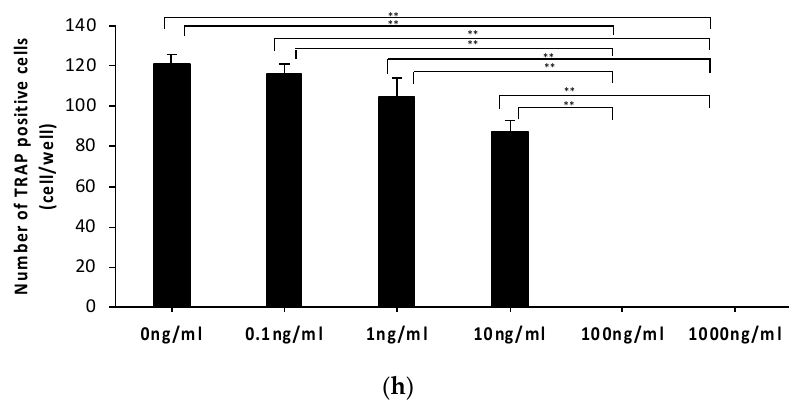
Figure 1. Anti-c-fms antibodies inhibit osteoclast formation and bone resorption in osteoblast–osteoclast precursor co-culture in vitro. ( a ) Microscopy images and ( b ) numbers of TRAP-positive cells in osteoblast–osteoclast precursor co-cultures treated with PBS, 1,25(OH) 2 D 3 and PGE2, 1,25(OH) 2 D 3 and PGE2 in the presence of anti-c-fms antibody (100 ng/mL), or anti-c-fms antibody (100 ng/mL) alone. ( c ) Microscopy images and ( d ) the percentage of resorption pits in osteoblast–osteoclast precursor co-culture treated with PBS, 1,25(OH) 2 D 3 and PGE2, 1,25(OH) 2 D 3 and PGE2 in the presence of anti-c-fms antibody (100 ng/mL), or anti-c-fms antibody (100 ng/mL) alone. ( e ) Levels of TRAP and ( f ) cathepsin K mRNA in osteoblast–osteoclast precursor co-cultures treated with PBS, 1,25(OH) 2 D 3 and PGE2, 1,25(OH) 2 D 3 and PGE2 in the presence of anti-c-fms antibody (100 ng/mL), or anti-c-fms antibody (100 ng/mL) alone analyzed by real-time PCR. mRNA levels for TRAP and cathepsin K were normalized to GAPDH. ( g ) Microscopy images and ( h ) numbers of TRAP-positive cells in osteoblast–osteoclast precursor co-cultures treated with 1,25(OH) 2 D 3 and PGE2 in the presence of various anti-c-fms antibody doses. Results are expressed as means ± SD. Statistical significance of differences between groups were determined using Scheffe’s test ( n = 4; ** p < 0.01 * p < 0.05). Scale bar = 200 μ m.